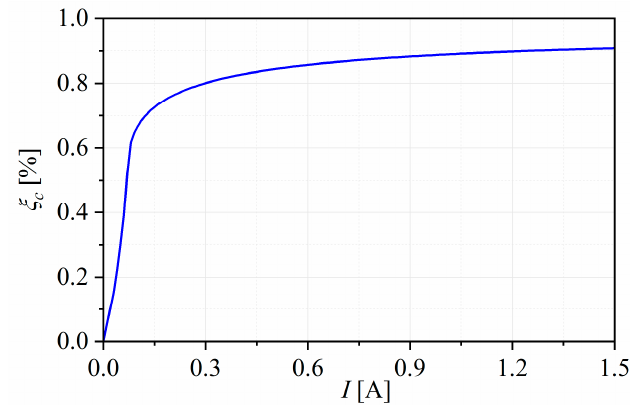
Appl. Sci. 2019 , 9 , x Figure 5. Core volume of MRD varied with applied current. Figure 5. Core volume of MRD varied with applied current.